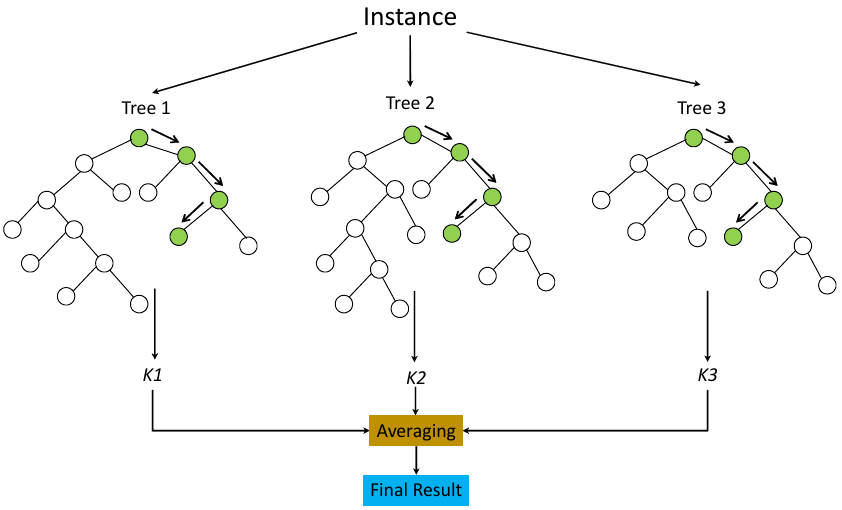
Figure 5. A simple sketch of a regression using a random forest.